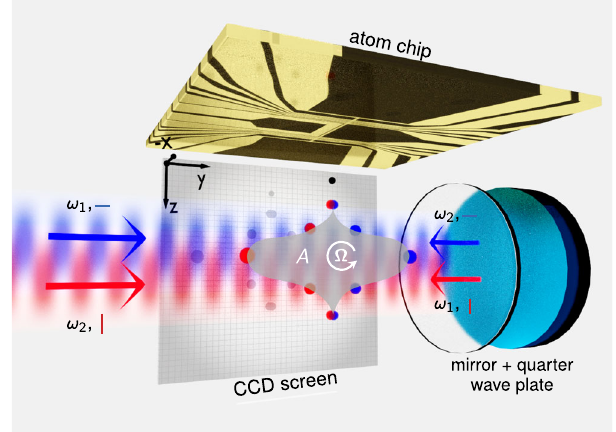
Fig. 1 Twin-lattice setup. The twin lattice is formed by retrore fl ecting light featuring two frequencies with linear orthogonal polarization. A quarter- wave plate in front of the retrore fl ector alters the polarization to generate two counterpropagating lattices (indicated in red and blue). After release from the atom chip and state preparation, the BEC is symmetrically split and recombined by the lattices driving double Bragg diffraction (DBD) and Bloch oscillations (BOs). In this way, the interferometer arms form a Sagnac loop enclosing an area A (shaded in gray) for detecting rotations Ω . The interferometer output ports are detected on a CCD chip by absorption